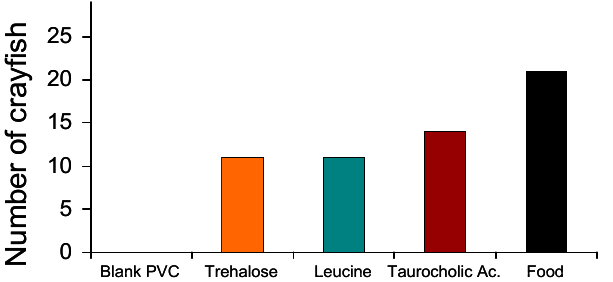
Figure 4. Attractiveness of trehalose, leucine and taurocholic acid in PVC, expressed as the number of crayfish that found the dispensers, as compared to food and blank PVC, within the established time (10 min). Data were obtained from 25 (14 females and 11 males) crayfish. In fact, although the food revealed the most effective stimulus by attracting 21 out of the 25 crayfish tested, 14 of them were also attracted by taurocholic acid and 11 by both trehalose and leucine. More than half of the crayfish found the PVC/food dispensers in less than 5 min (Figure 5A); PVC dispensers with trehalose, leucine and taurocholic acid were found in the same time by 36–40% of the animals. Moreover, 68% of crayfish spent more than 10 s on the PVC/food dispensers (Figure 5B) in prolonged inspections and/or leg-manipulation of them trying to eat it. Only 28% and 32% of the animals spent more than 10 s on the PVC dispensers containing trehalose and taurocholic acid, respectively. PVC/leucine dispensers resulted in short visits and only 8% of the crayfish spent more than 10 s on these dispensers.